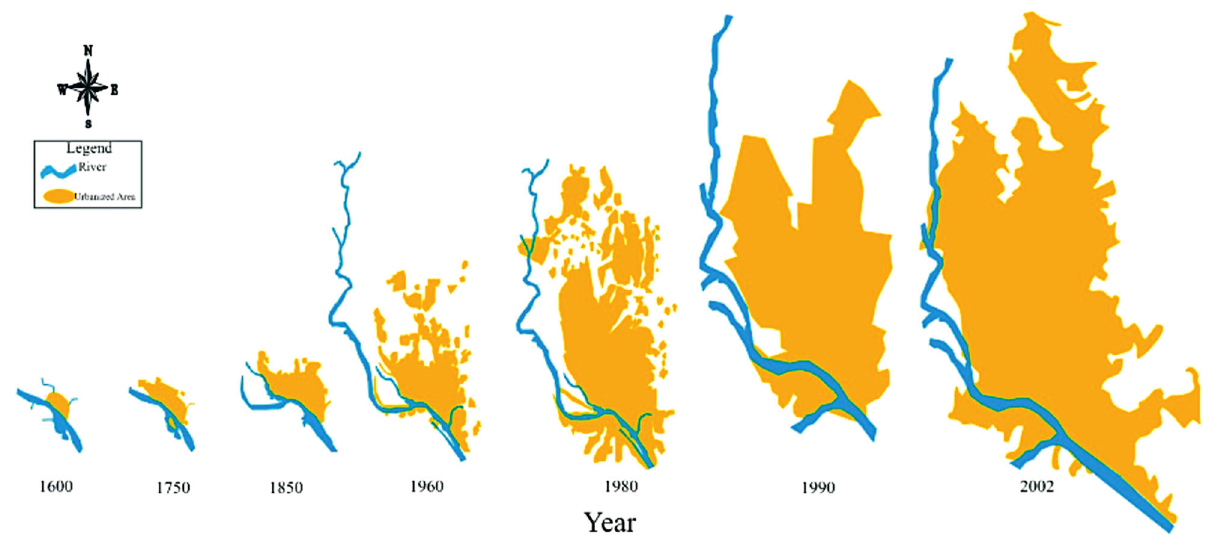
Figure 2. The historical growth of Dhaka City (not to scale). Source: Urban Planning Department, Dhaka City Corporation,